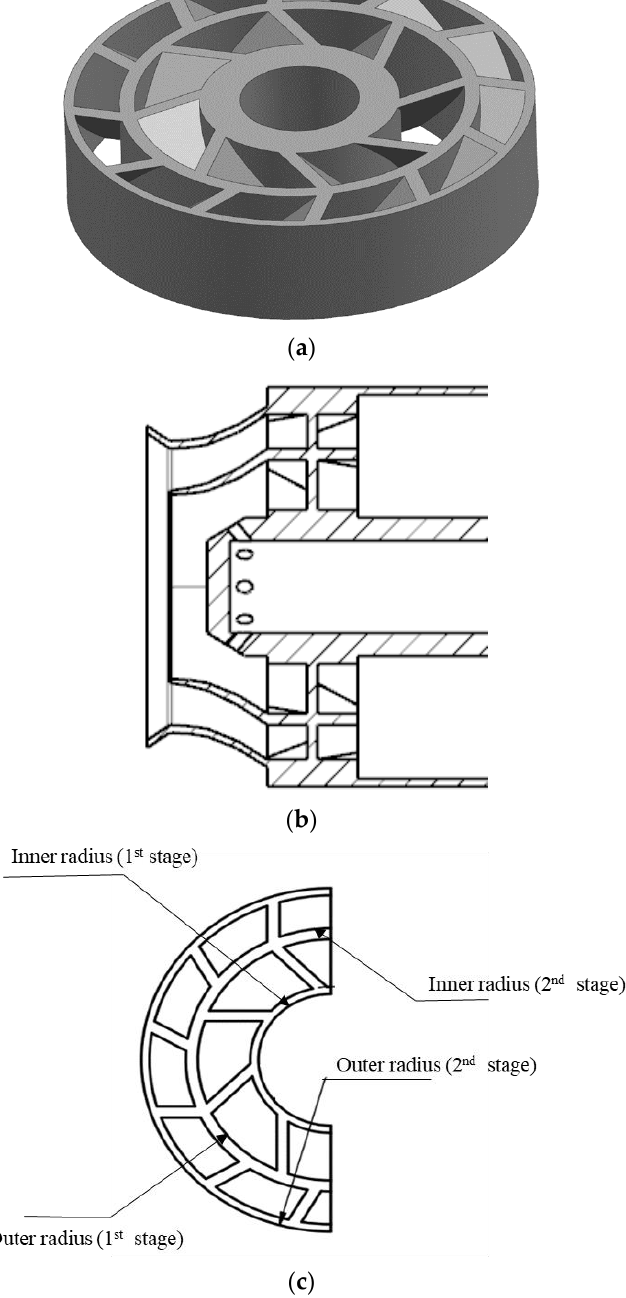
Figure 1. Structure sketch of swirler. ( a ) Swirler structure; ( b ) Geometry of the injection unit; ( c ) Swirler parameters.